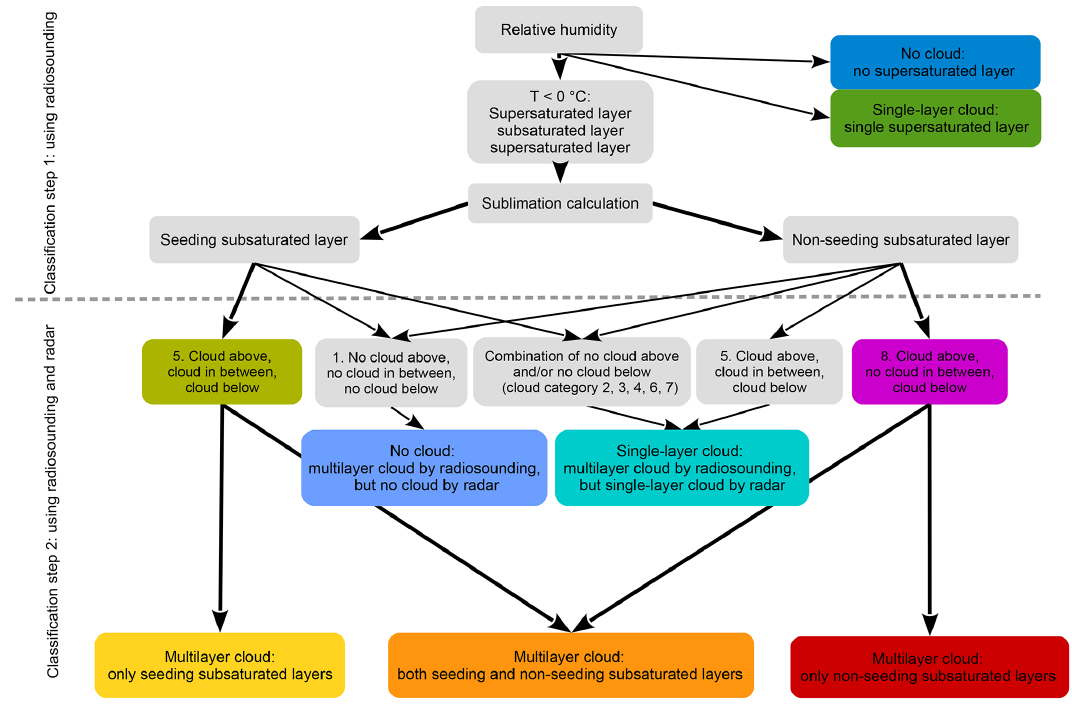
Figure 1. Overview of classification schemes: first only radiosonde data are used to detect one subsaturated layer in between two supersat- urated layers, one just above and one just below. If this combination is found, then for the subsaturated layer the calculation of sublimation leads to seeding or non-seeding cases. Liquid layers above 0 ◦ C are not considered. In the second step radar reflectivity factor data are added in order to detect cloud occurrence inside the investigated supersaturated layer above ( cloud above ), subsaturated layer in between ( cloud in between ) and supersaturated layer below ( cloud below ). The cloud category 5 (cloud above, cloud in between, cloud below) is counted as seeding MLC since it is most likely the seeding resulting in a radar signal in the subsaturated layer in between the cloud layers. The colours yellow, orange and red represent the resulting MLC categories.